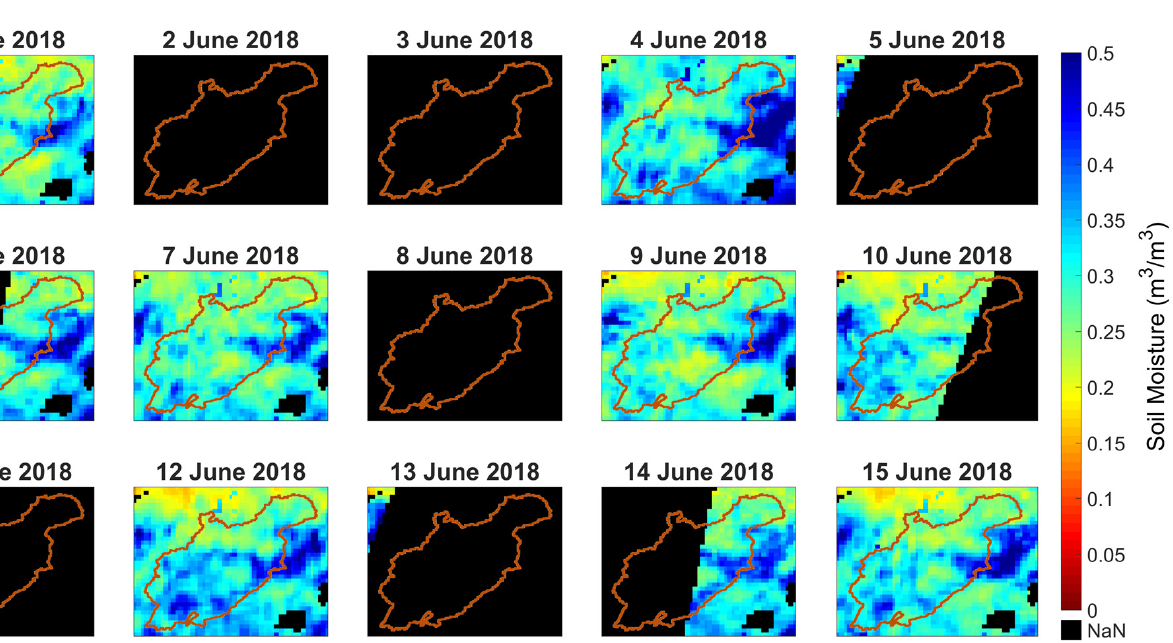
Figure 2. Spatiotemporal gaps in SMAP data over the study area from 1 June 2018 to 15 June 2018.